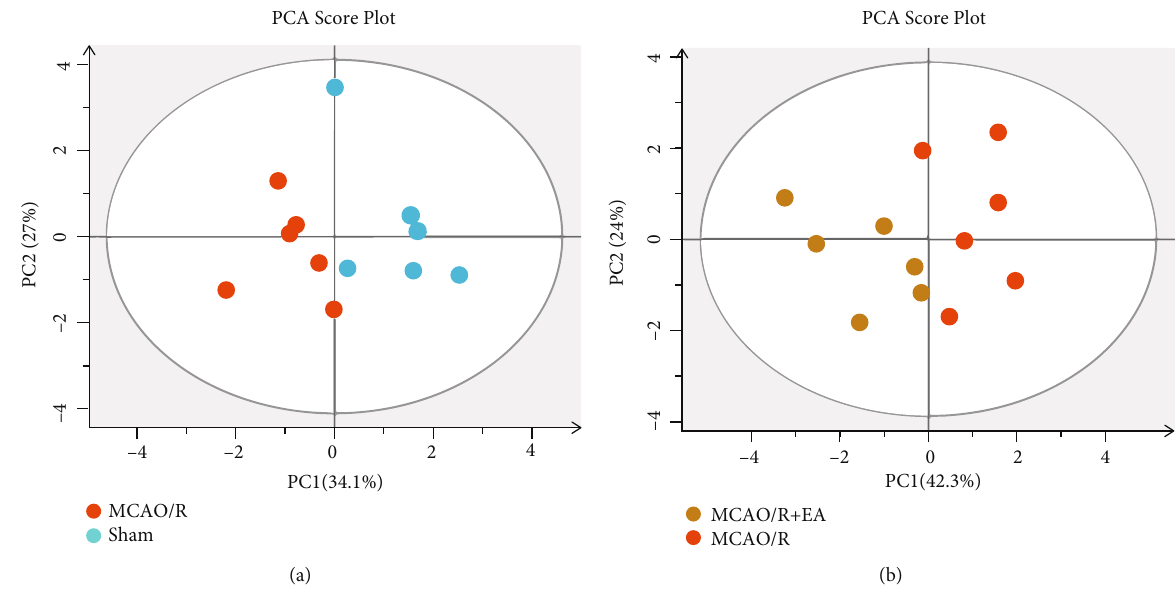
Figure 5: Principal component analysis score plots. (a) MCAO/R group vs. sham group, X interpretation rate = 0 : 611 . (b) MCAO/R+ EA group vs. MCAO/R group, Xinterpretation rate = 0 : 663 . R 2 (X) is the interpretation of the model. Usually, R 2 higher than 0.5 is